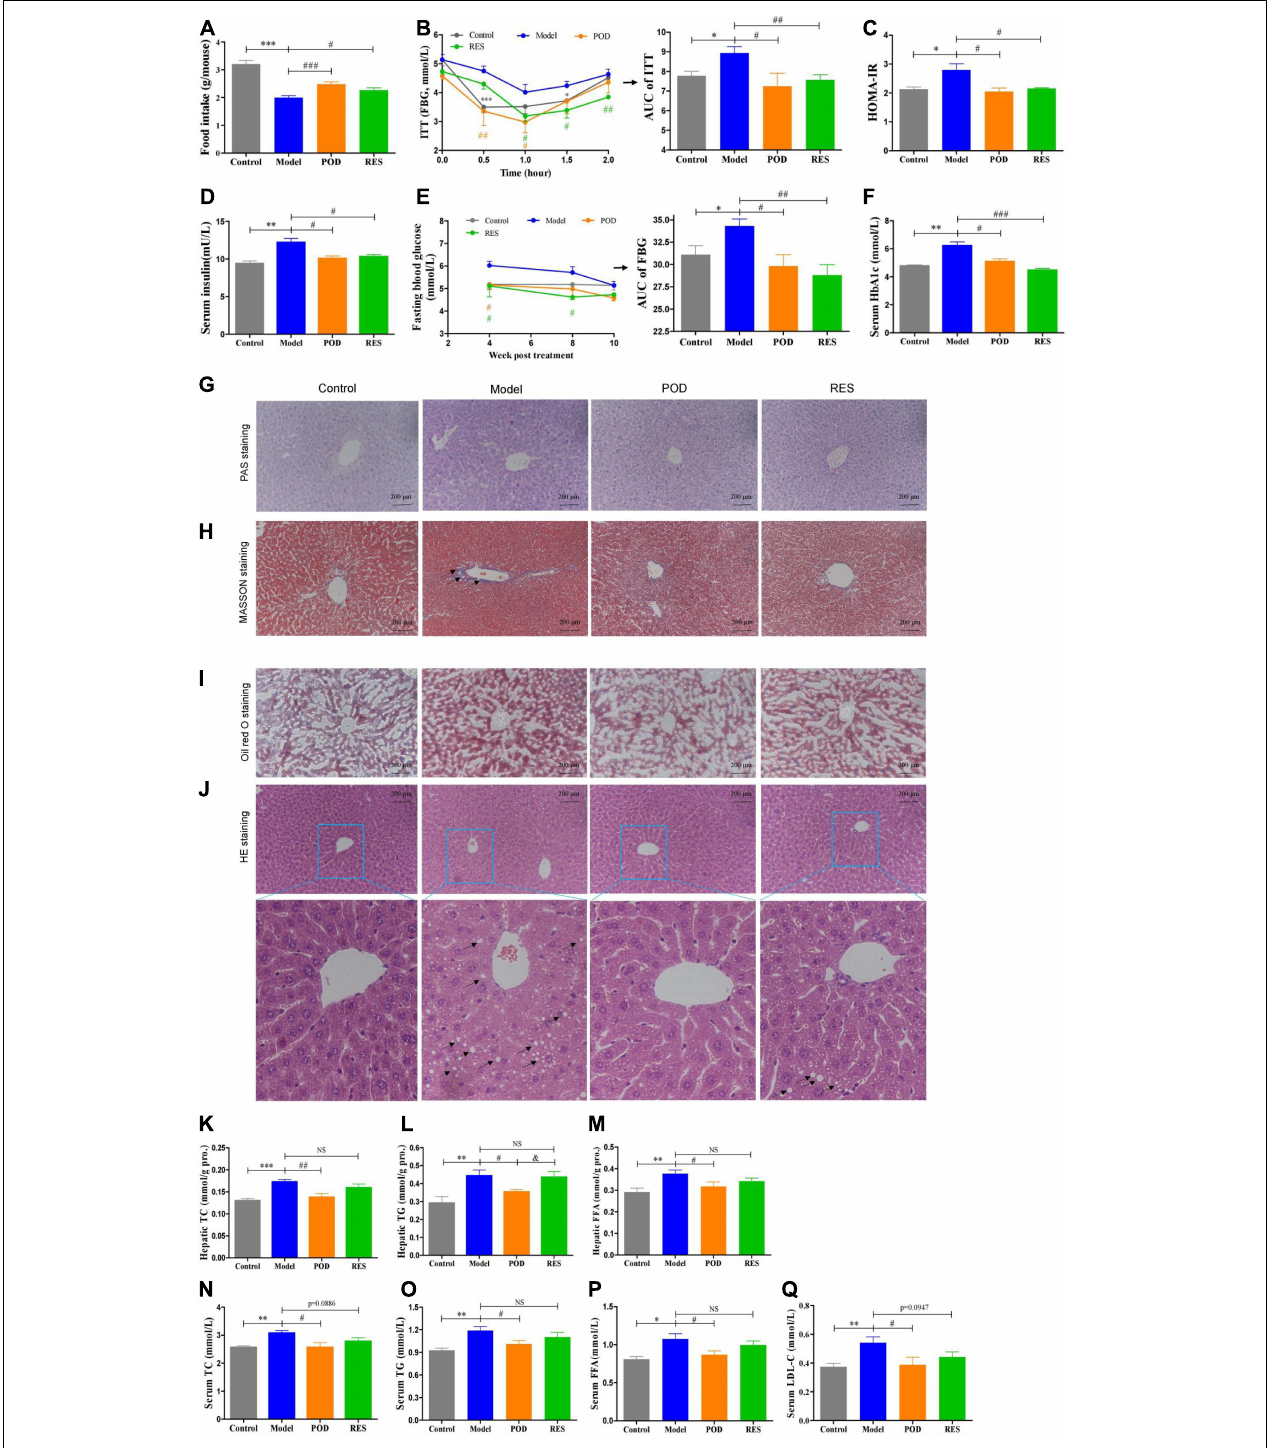
FIGURE 3 | Effects of POD and RES on glucolipid metabolism and fatty liver. (A) Food intake. (B) Insulin tolerance test (ITT) and the area under the curve (AUC). (C) Homeostasis model assessment -insulin resistance (HOMR-IR, HOMA-IR = Glucose [mmol/L] × Insulin [mU/L] ÷ 22.5). (D) Serum insulin level. (E) Fasting blood glucose level (FBG) and AUC of FBG. (F) Serum HbA1c level. (G–J) Hepatic periodic acid-schiff (PAS) (200 × ), MASSON (200 × ), Oil red O (200 × ), and HE stainings (200 × ), respectively. (K–M) Total cholesterol (TC), triglycerides (TG), and free fatty acid (FFA) in liver, respectively. (N–Q) Serum levels of TC, TG, FFA, and low-density lipoprotein-cholesterol (LDL-C), respectively. Data are presented as mean ± SEM. ∗ p < 0.05, ∗∗ p < 0.01, ∗∗∗ p < 0.001. # p < 0.05, ## p < 0.01, ### p < 0.001, compared to model group. & p < 0.05, compared to POD group. NS, p > 0.05.